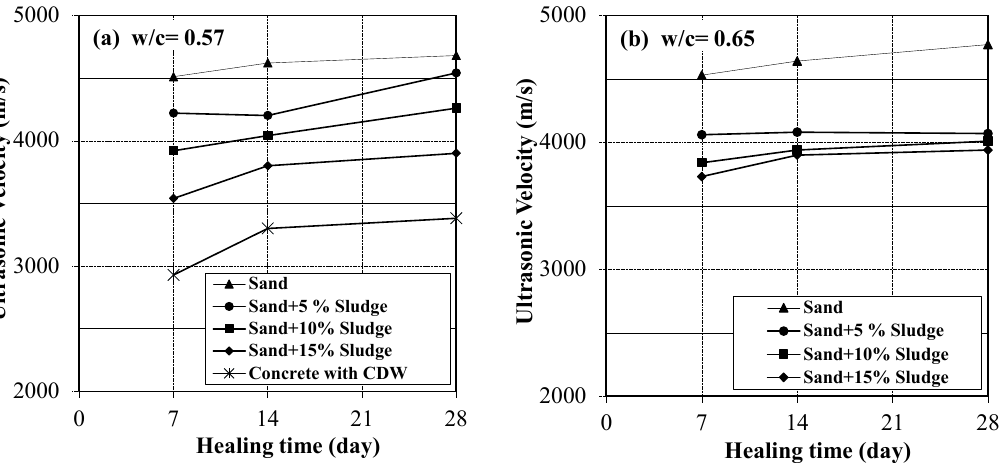
Figure 6. Ultrasonic velocity versus healing time for: ( a ) conventional concrete, concrete with sewage sludge, and with CDW [27] for w/c = 0.57; and for ( b ) conventional concrete and concrete with sewage sludge for w/c = 0.65.